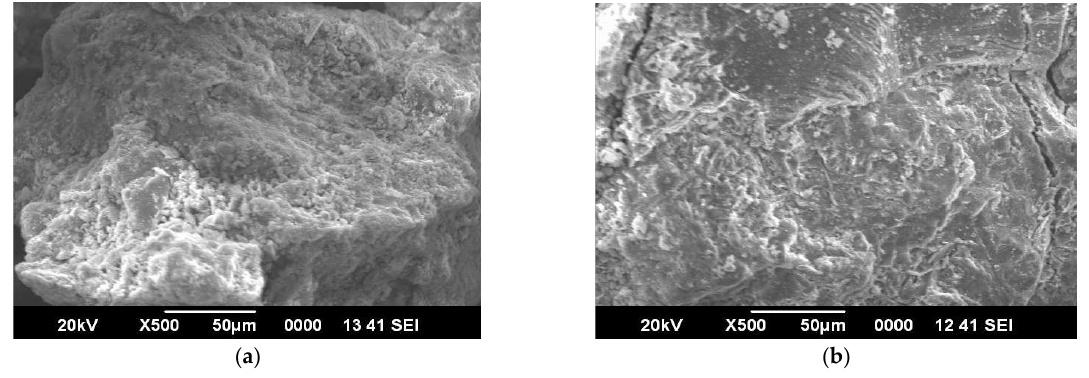
Figure 8. ( a ) SEM image of M1; ( b ) SEM image of M6.